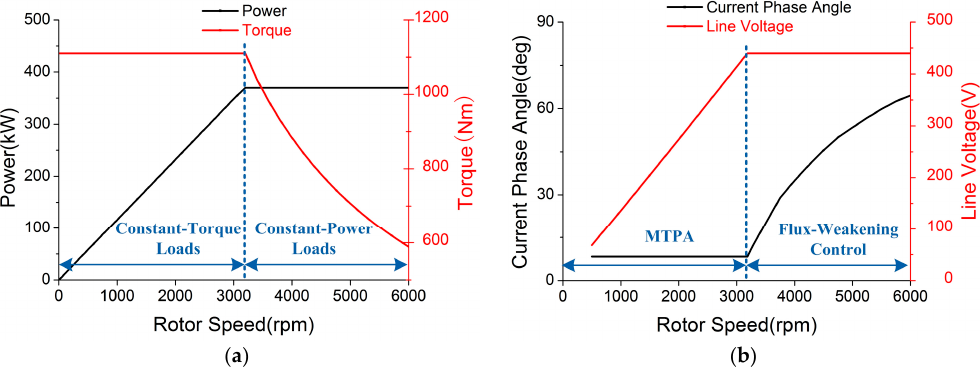
Figure 3. Operating characteristic curve and driving condition of the SPM Machine. ( a ) Operating characteristic curve of the SPM Machine; ( b ) Driving condition of the SPM Machine.